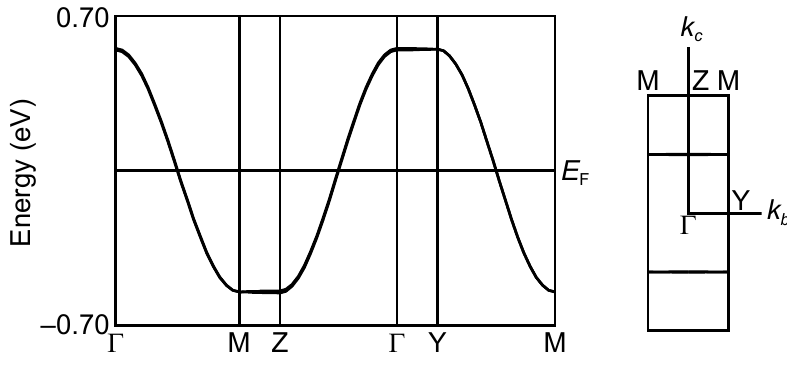
Figure 7. Calculated band dispersion (left) and Fermi surfaces (right) for 4